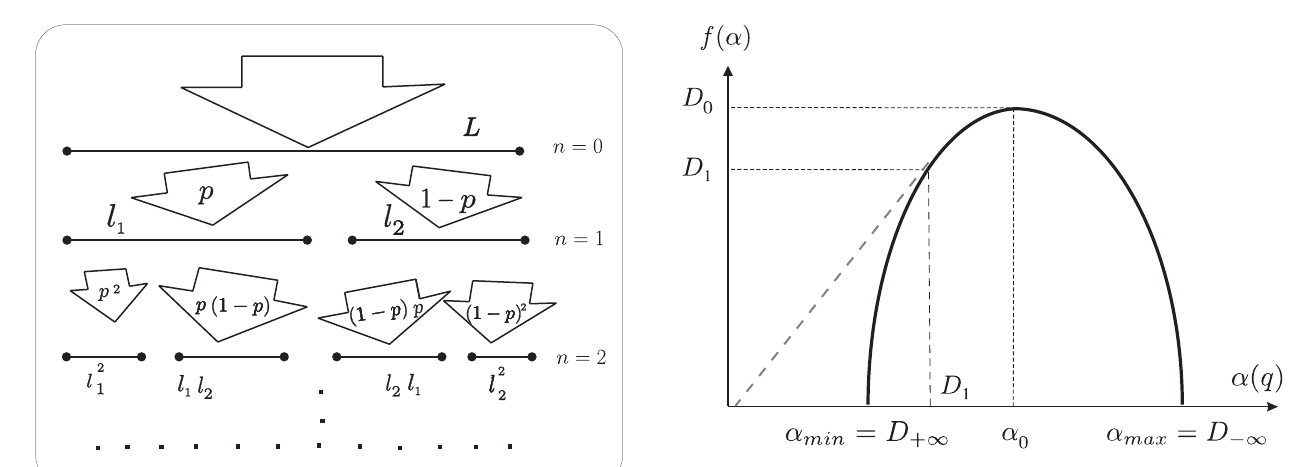
Fig. 2. The singularity multifractal spectrum f (α) versus the sin- gularity strength α with some general properties: (1) the maximum value of f (α) is D 0 ; (2) f (D 1 ) = D 1 ; and (3) the line joining the origin to the point on the f (α) curve, where α = D 1 , is tangent to the curve, as taken from Ott